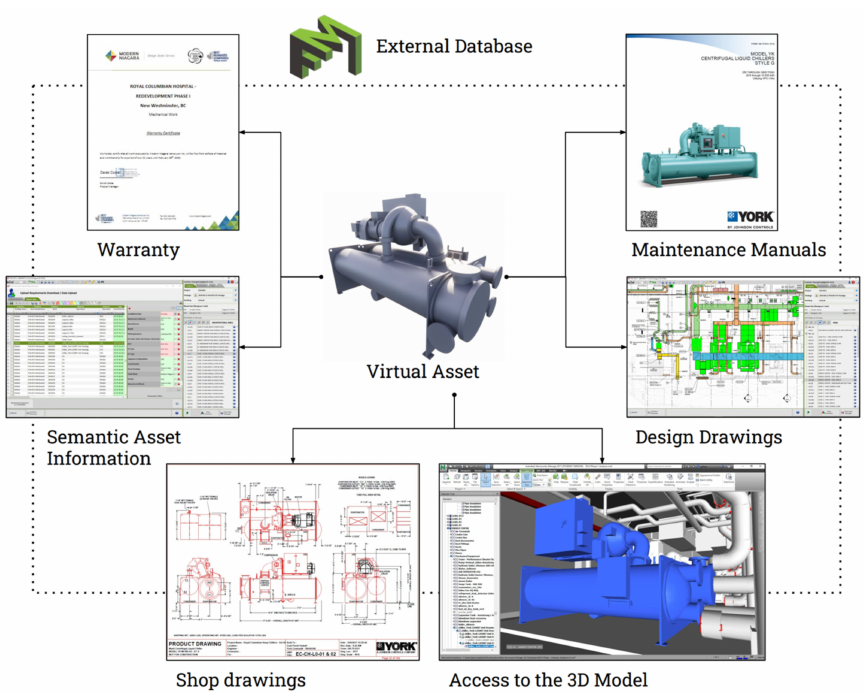
Figure 13. Representation of asset information available (Chiller) in the external